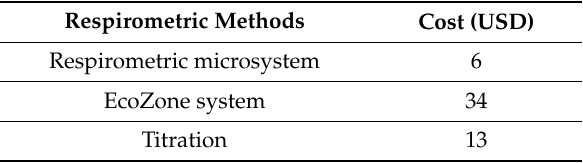
Table 2. Respirometric test cost analysis under different respirometric methods.